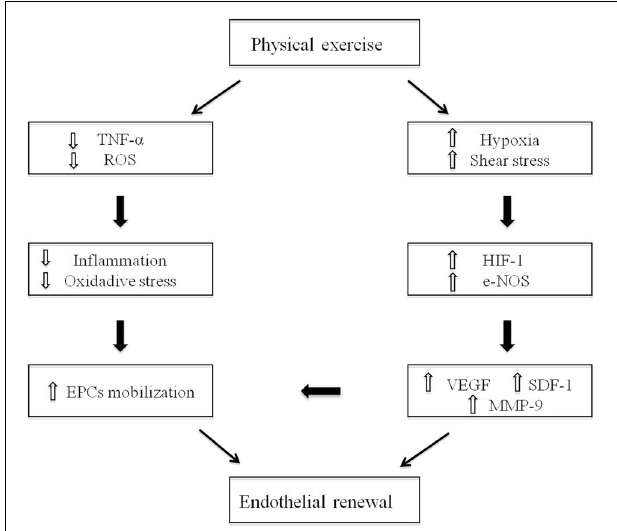
FIGURE 1 | Effects of physical exercise on endothelial function and